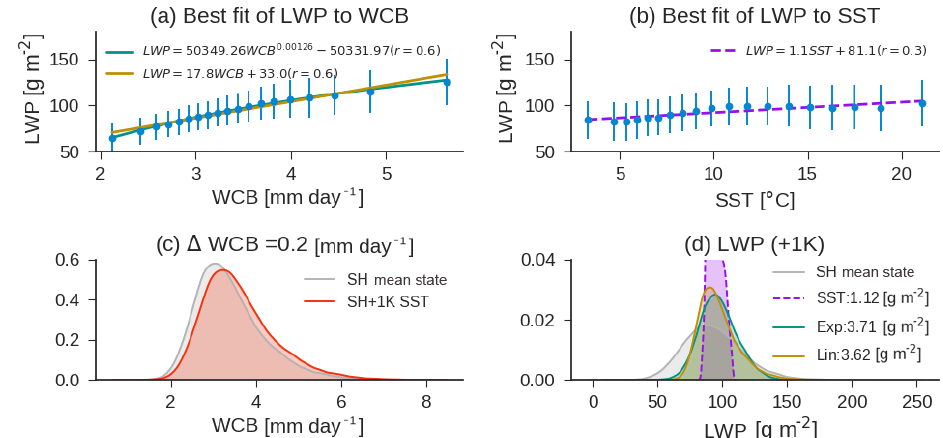
Figure 6. (a) The LWP CM observed in SH as a function of the WCB moisture flux; the best fit line to the observations using the form LWP CM = a · WCB b + c is shown using a green line. A simple linear fit is shown in yellow. The observations are binned into equal quantiles for visual clarity. Error bars show a standard deviation within each bin. (b) The fit of cyclone LWP CM to SST CM . (c) The distribution of SH WCB moisture flux in the current climate, and when the WVP moisture flux is scaled by 1.06 consistent with a uniform 1K increase in SST. The difference in the WCB moisture flux is noted in the title. (c) The distribution of LWP CM in the current climate and as predicted by the fits shown in (a) and (b) . The LWP CM when SST is increased by 1K as predicted by the fits in (a) is based on scaling WVP by 1.06. The LWP CM predicted by the fit shown in (b) is based on SST increasing uniformly by 1K. The mean difference of LWP CM between the prediction and the climate mean state is noted in the legend.